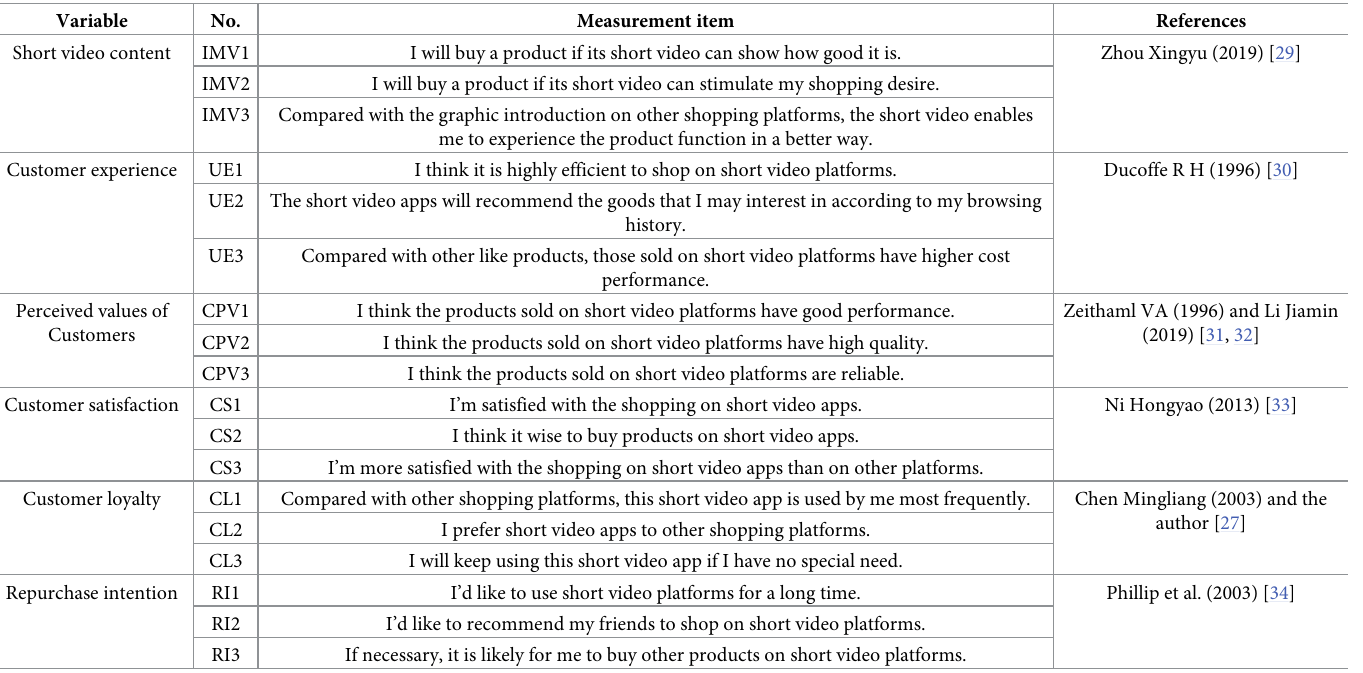
Table 1. Variables and measurement